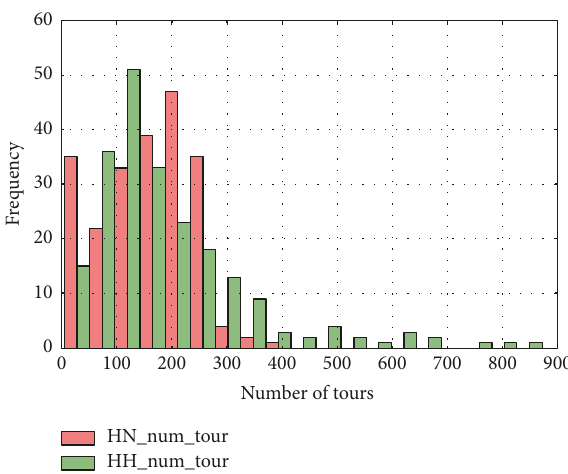
Figure 2: Histogram of number of HH and HN